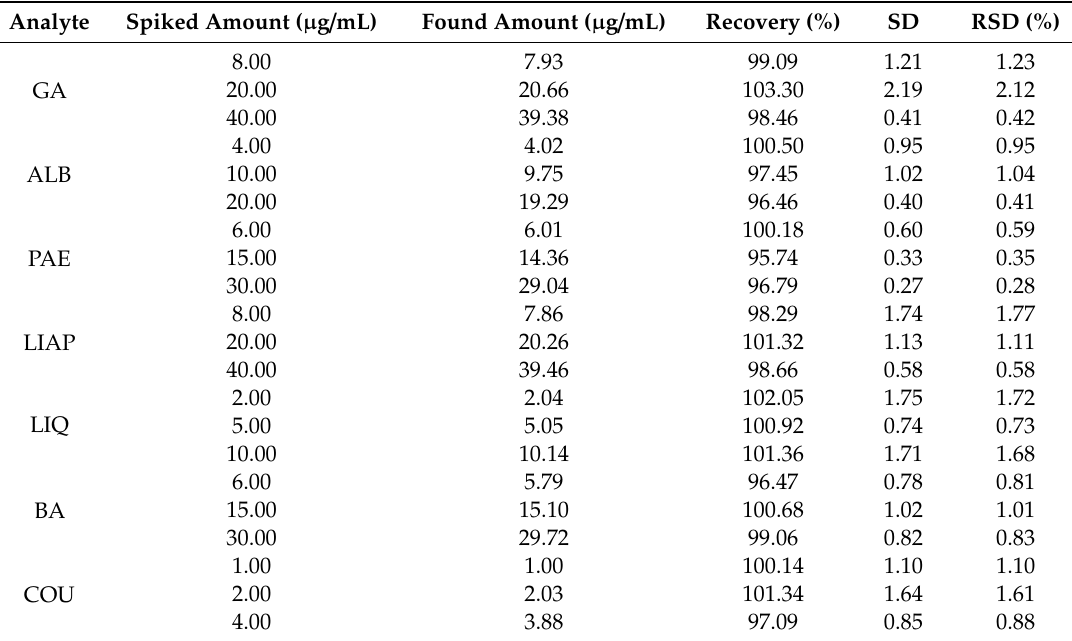
Table 2. Extract recovery tests for the 12 marker analytes in SGJT. Analyte Spiked Amount ( µ g /